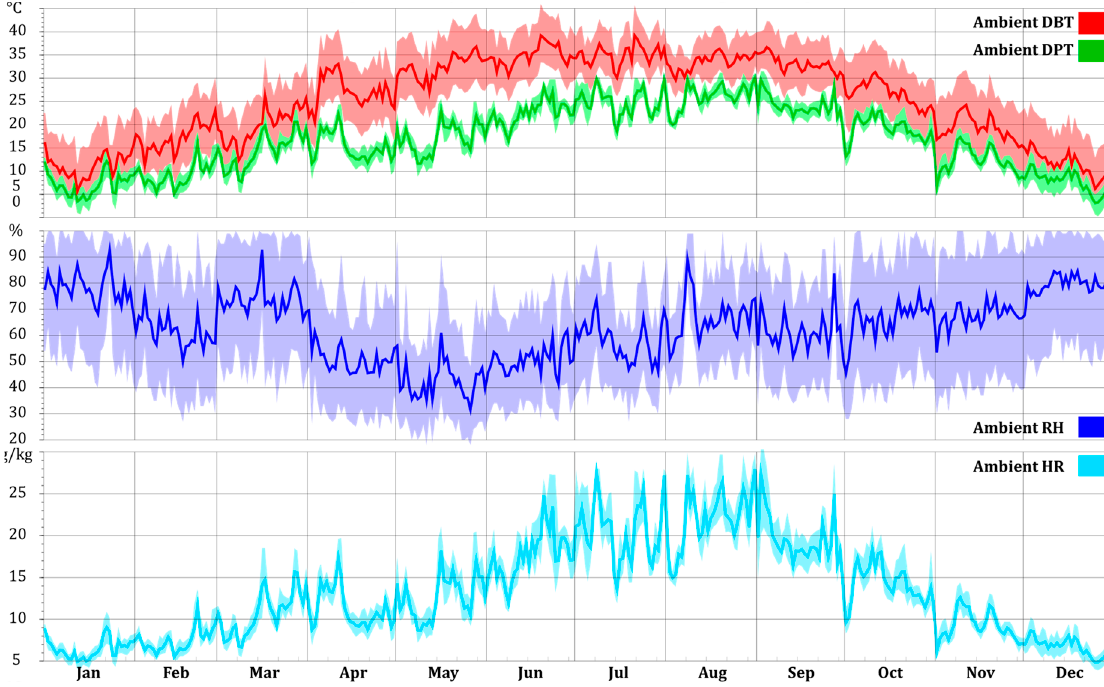
Figure 8. Profile of annual climatic ambient air conditions of Multan (Pakistan). The standalone DAC system created a maximum temperature gradient, i.e., 8.4 °C more at ambient conditions of 38.6 °C with a humidity ratio of 21.6 g/kg at ambient con- ditions of 25 g/kg, which lies well outside the required greenhouse optimum temperature and humidity conditions (Figure 9a). It is worth mentioning that the temperature gradient is defined as the difference between the dry bulb temperature of the ambient air and the dry bulb temperature of the product air at the system outlet node. The studied standalone DAC system created unsuitable thermal and humidity conditions inside the greenhouse throughout the year due to a relatively higher temperature and very dehumidified air (Figure 9a). According to Figure 9b, the standalone DAC system coupled with a sensible heat exchanger (DAC+HX) (working efficiency assumed to be 0.9) created a maximum temperature gradient, i.e., 0.77 °C more at ambient conditions of 39.2 °C with a humidity ratio of 16.8 g/kg at ambient conditions of 24.3 g/kg, which lies slightly outside the re- quired greenhouse optimum temperature and humidity conditions (Figure 9b), and is very close to ambient air conditions. The studied DAC+HX system created very close thermal and humidity conditions to ambient conditions inside the greenhouse throughout the year. Figure 9c shows the psychrometric profile of temperature and relative humidity of the desiccant dehumidification-based Maisotsenko cycle evaporative cooling (M-DAC) system for the climatic conditions of Multan (Pakistan). According to Figure 9c, most of the hourly points of the M-DAC system lie inside the required thermal and humidity con- ditions of the greenhouse environment. The M-DAC system created a maximum temper- ature gradient i.e., 21.98 °C. According to Figure 9c, the M-DAC system coupled with a sensible heat exchanger (working efficiency assumed to be 0.9) created a maximum tem- perature gradient i.e., 21.9 °C more at ambient conditions of 39.2 °C with a humidity ratio